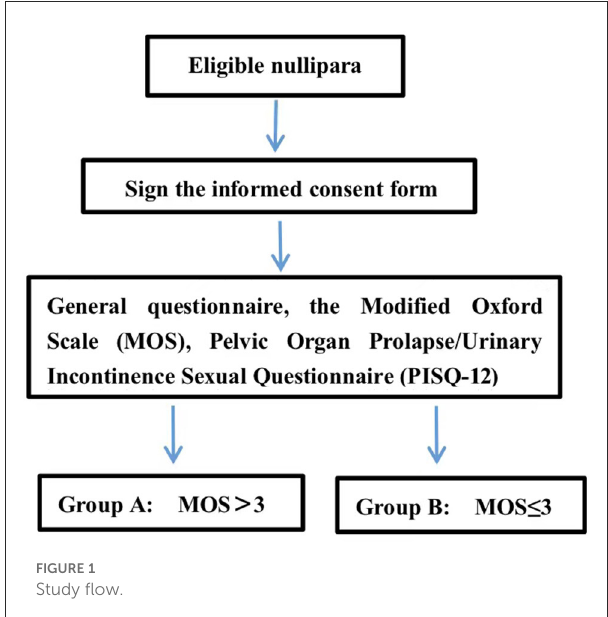
FIGURE1 Study flow. Categorical variables were described as numbers and percentages.